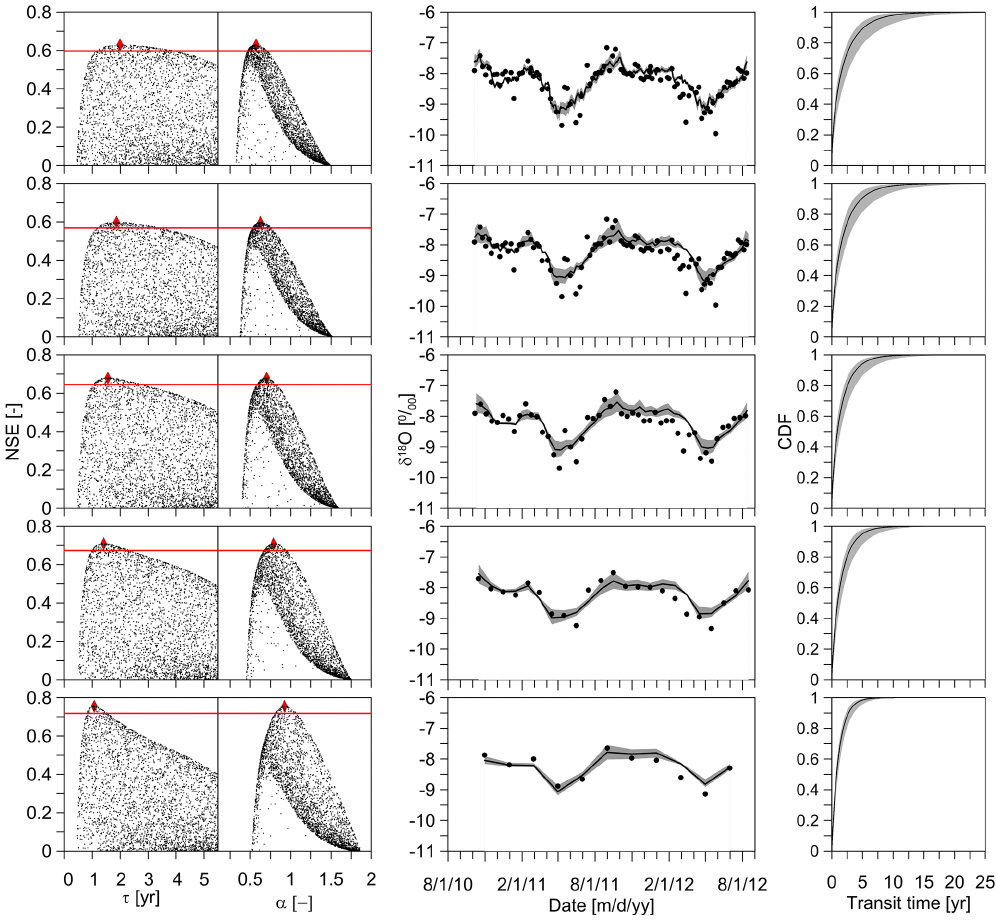
Figure 5. Predicted results for the stream water site PL using the gamma lumped model (GM). Results are ranged from top to bottom according to the data resolution: daily (top panels), weekly, bi-weekly, monthly and bi-monthly (bottom panels). Left column panels show dotty plots for the model parameters ( τ and α ) according to NSE using Monte Carlo random simulations (GLUE approach). Red line shows the feasible range of behavioral solutions of model parameters as a 5% of the top best prediction (red diamond). Center column panels show the measured (black filled circles) and simulated δ 18 O (the black line and the shaded area represent the best possible solution and its range of variation according to the 5–95% of weighted quantiles derived from the confidence limits of behavioral solutions shown in the left column). Right column panels: stream water transit time distribution function corresponding to the best NSE; gray shaded area in each plot corresponds to the range of possible shapes of the distribution